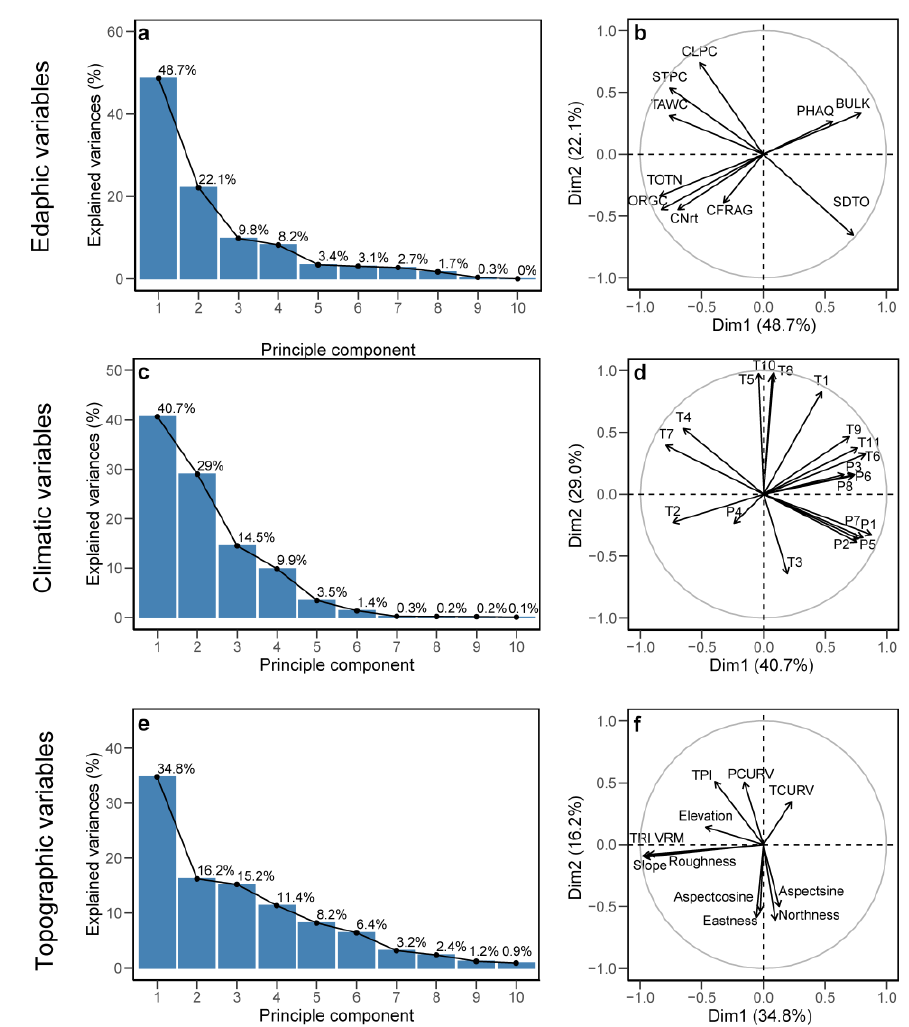
Figure 4. Principal component analysis of edaphic (( a ) and ( b ); first row), climatic (( c ) and ( d ); second row) and topographic (( e ) and ( f ); third row) variables at the managed grassland sites. See Table A1 for detailed descriptions of the variables. The first column shows the loadings of each environmental variable to the top two most important principal components (PCs); the second column shows the percentage of explained variances of the first ten PCs.